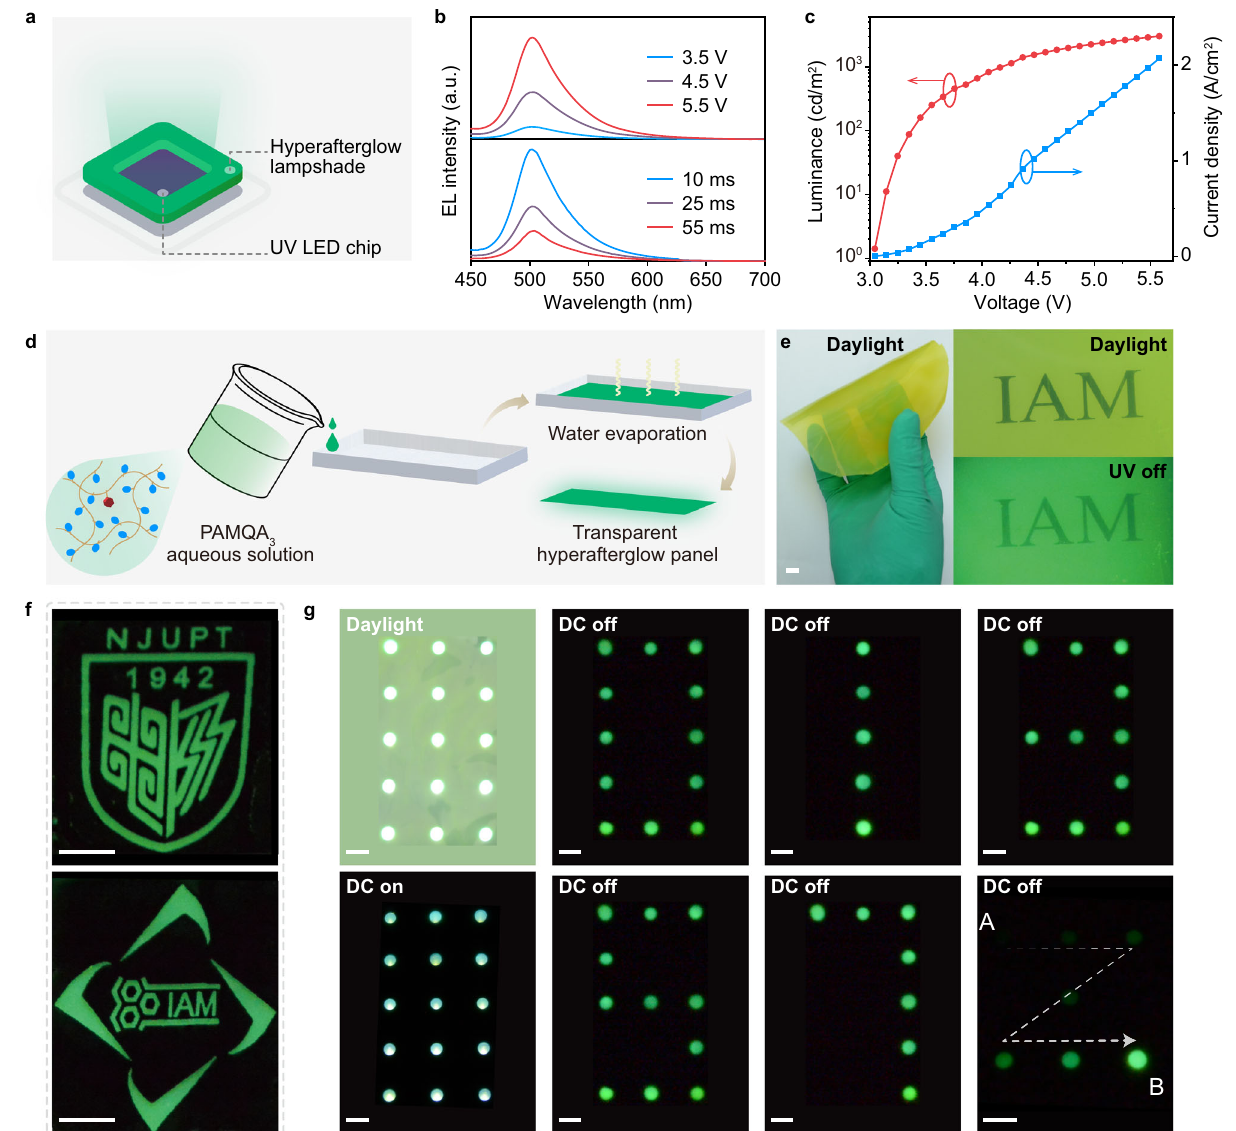
Fig. 5 | Demonstration of hyperafterglow lighting and display. a Schematic diagram of hyperafterglow LED. b SSEL (top panel) and delayed EL (bottom panel) spectra of hyperafterglow LED at varied driving voltages (top panel) and delayed times (bottom panel). c Current density – voltage – luminescence curves of hyper- afterglowLED. d Fabricationoftransparenthyperafterglowpanel. e Photographsof the fabricated large area hyperafterglow panel under daylight and ceasing of UV